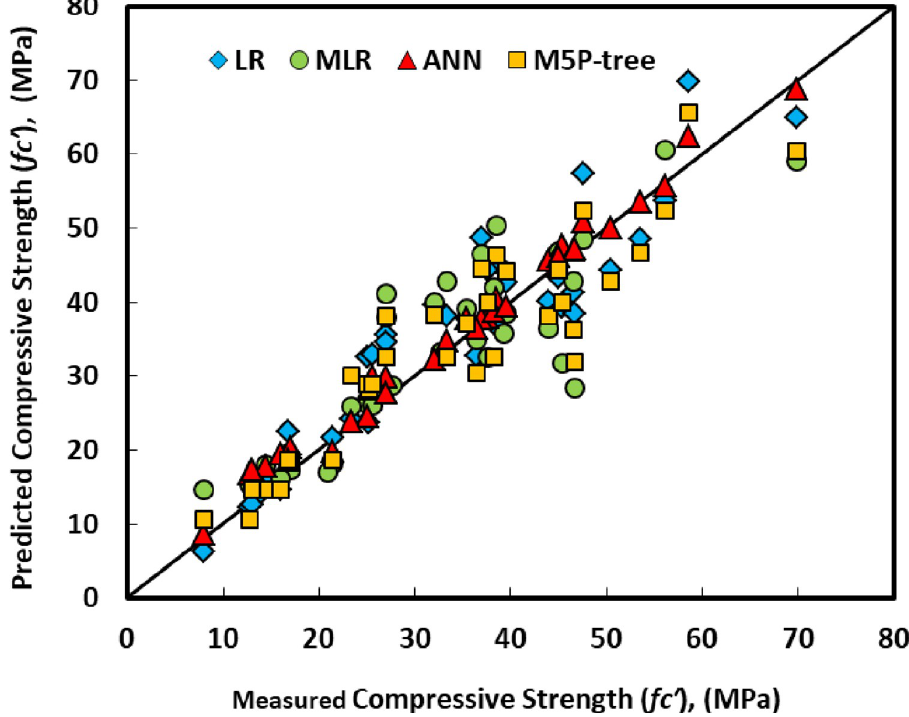
Fig 21. Model projections of compressive strength of GGBS/FA-GPC mixtures using testing data.